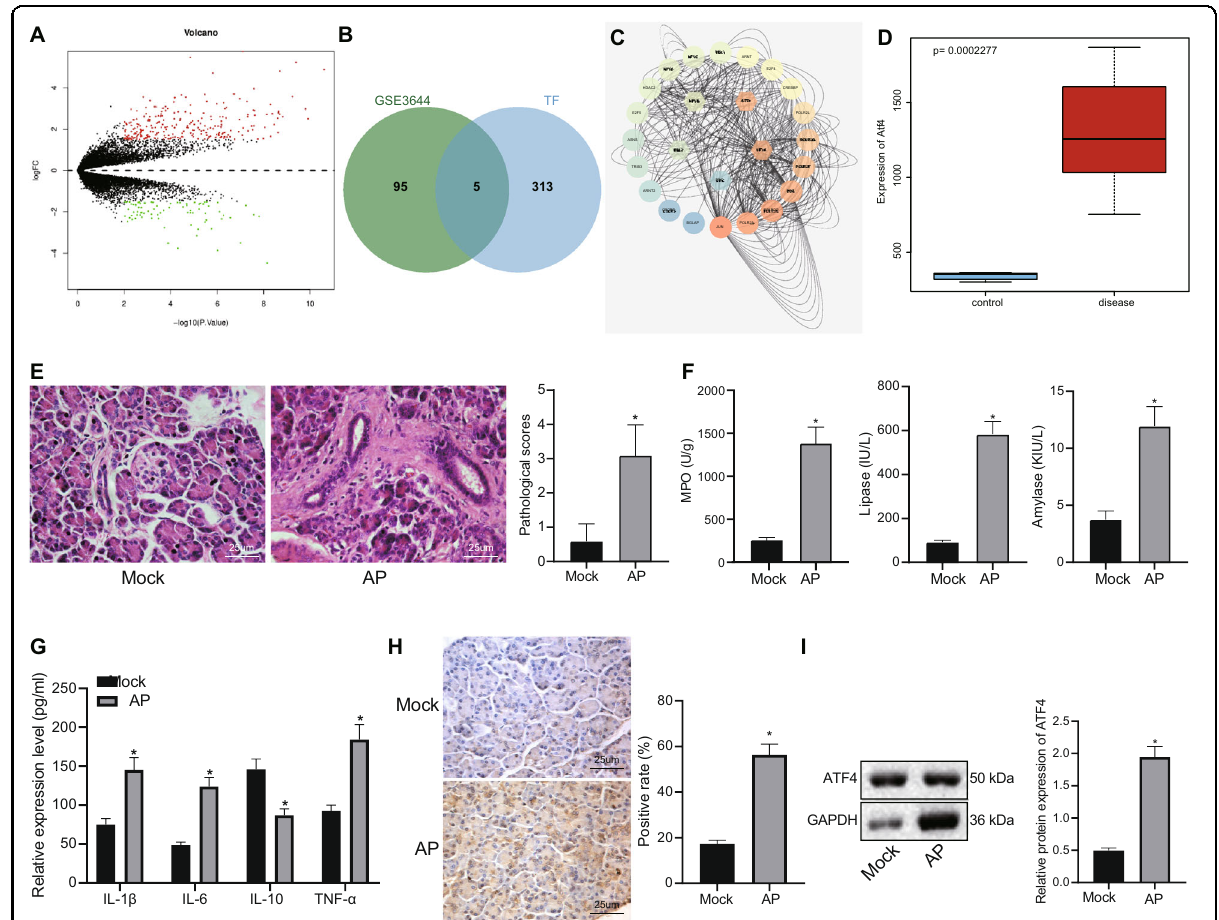
Fig. 1 Highly expressed ATF4 is found in AP. A Volcano map of differentially expressed genes obtained by the difference analysis of microarray dataset GSE3644. Red dots indicate genes that are signi fi cantly upregulated, green dots indicate genes that are signi fi cantly downregulated, and black dots indicate insigni fi cant genes. B Comparison results of differentially expressed genes in microarray dataset GSE3644 with transcription factors. The fi ve intersecting genes are ATF4, HIF1A, NFYB, RBL2, and SRC. C The PPI network of important transcription factors and related genes constructed by GeneMANIA. The fi ve hexagonal genes placed in the middle are the input genes, and the rounded genes are the predicted related genes. The higher the core level, the bluer the lower the core level. D Box line diagram ( p = 2.28e − 04) of ATF4 expression data in microarray dataset GSE3644. The blue box on the left indicates the expression of normal samples, and the red box on the right indicates the expression of the pancreatitis sample. E H&E staining to detect pathological conditions of pancreatic tissue. F Biochemical analysis to detect peroxidase, serum amylase, and serum lipase levels. G ELISA to detect serum IL-1 β , IL-6, IL-10, and TNF- α . H ATF4 expression in pancreatic tissues detected by immunohistochemistry. I ATF4 expression in pancreatic tissue detected by western blot analysis. * p < 0.05 compared with the Mock group (normal control). The comparison of the measurement data (mean standard ± deviation) between two groups were tested by independent sample t -test, n =